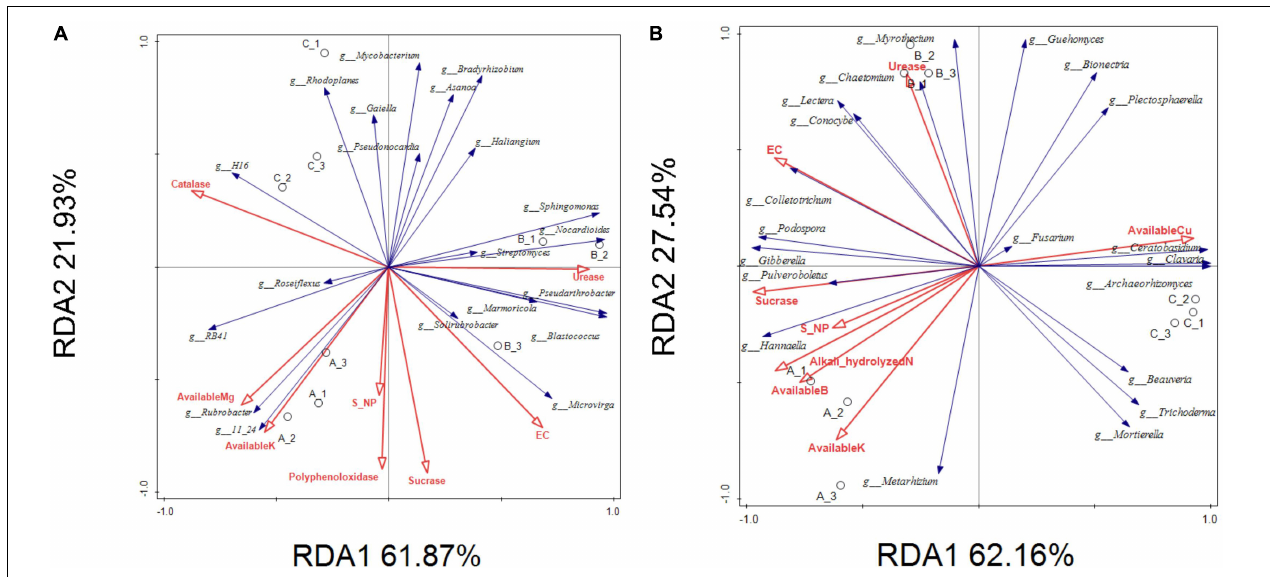
FIGURE 12 | RDA correlation analysis of soil physical and chemical properties with Top20 bacteria. (A) and Top20 fungi (B) .